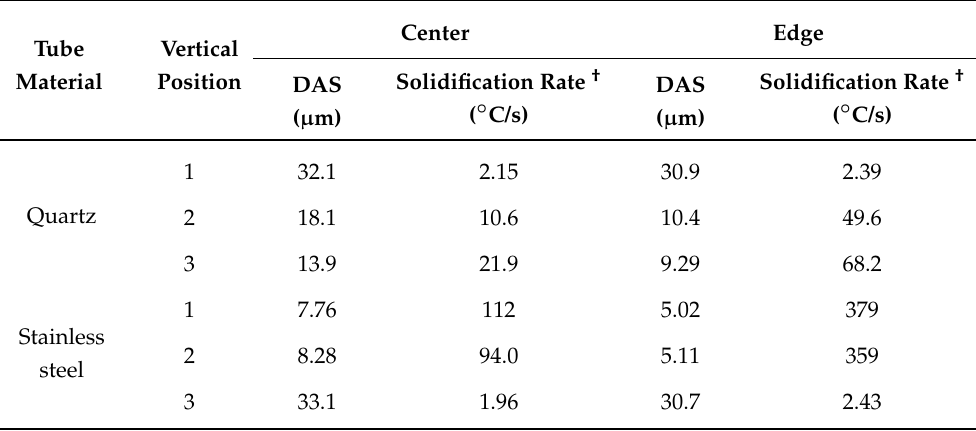
Table 2. Dendrite arm spacing and solidification rate of the fluidity samples of the A356 alloy at 650 ◦ C of the melt temperature and 0.01 MPa of the vacuum degree.